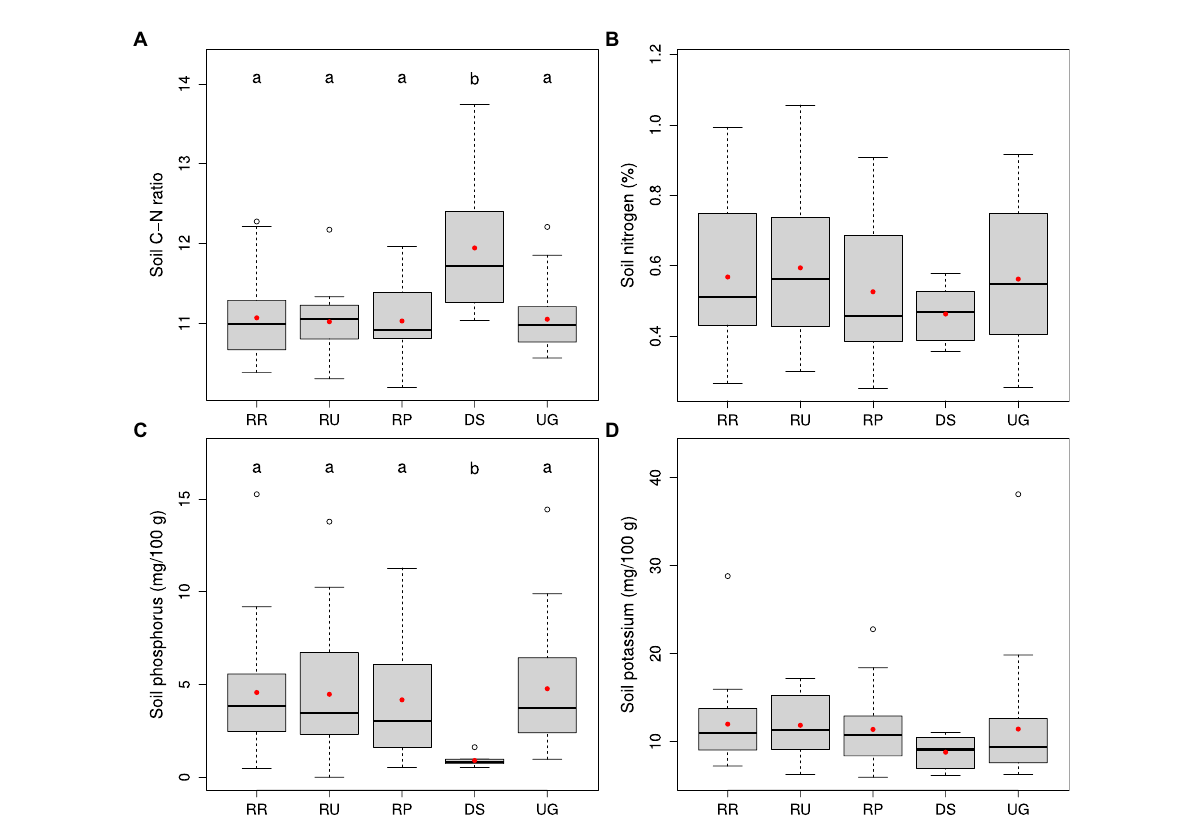
FIGURE 3 Box-whisker plots of the soil C/N ratio (A) , total nitrogen (%; B ), plant-available P (mg/100 g; C ), and plant-available K (mg/100 g; D ) in 2021 on the different site categories—donor sites (DS, n = 8), all restoration sites with treatments ploughed (RP), rotovated (RR), and untilled (RU), and unrestored reference grassland (UG; n = 20, respectively). Plot data were averaged on the treatment level or, in case of DS and UG, on the site level. Red dots display the mean values. Significant differences ( p < 0.05) are indicated by different letters above the boxes (testing on ln-transformed data for soil P and soil